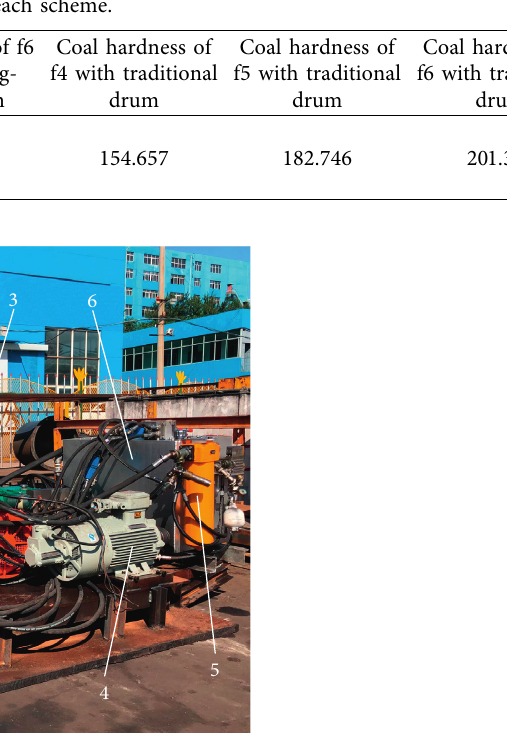
Figure 11: Test device. 1. Cutting mechanism, 2. Ranging arm, 3. Double piston hydraulic drive rotary motor, 4. Three plunger hydraulic drive linear motor, 5. Water-cooled cooler, 6. Hydraulic control unit.